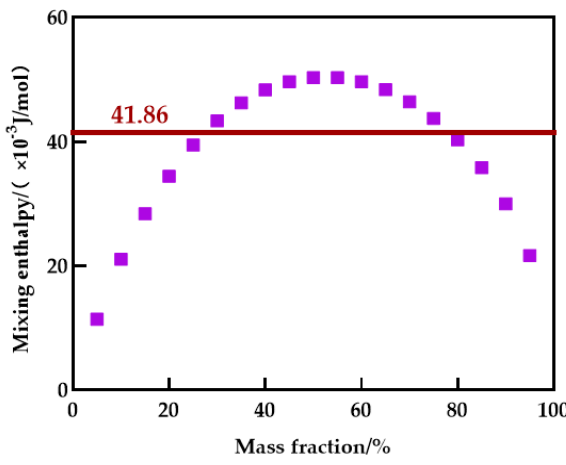
Table 7. Main parameters of blend polymers.